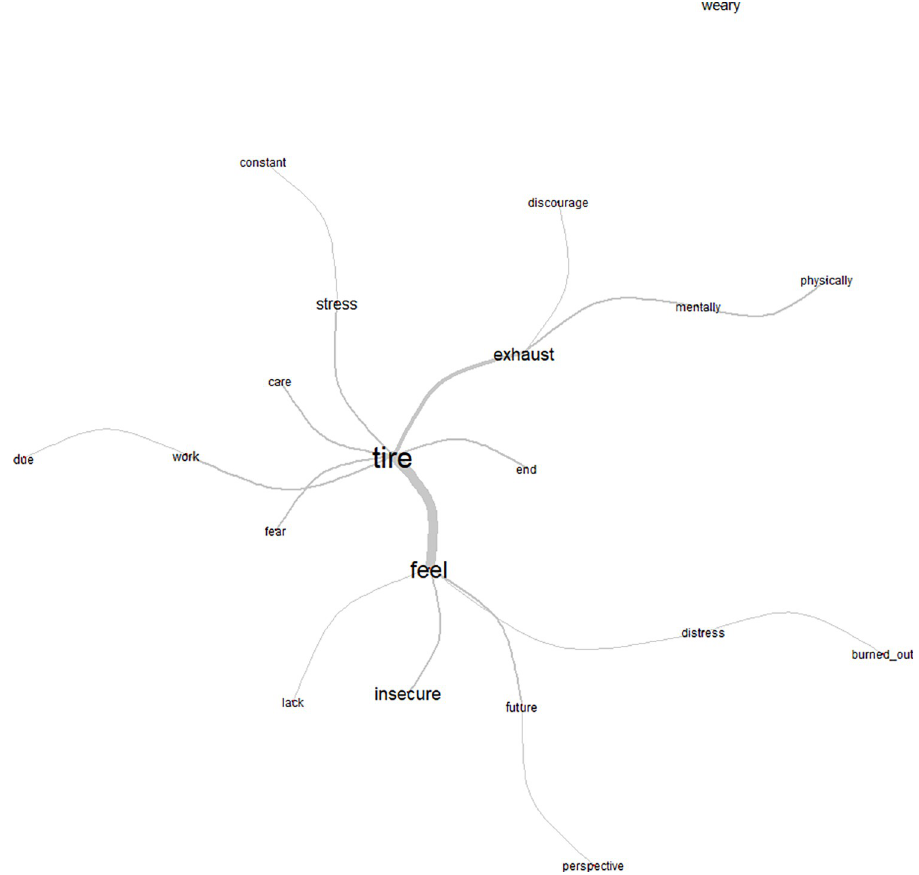
Fig 6. Similarity tree for Class 4: Fatigue and burnout in the pandemic. Source: COVIDPRO Project (2020). Rio de Janeiro–Brazil, 2020. (N = 554).